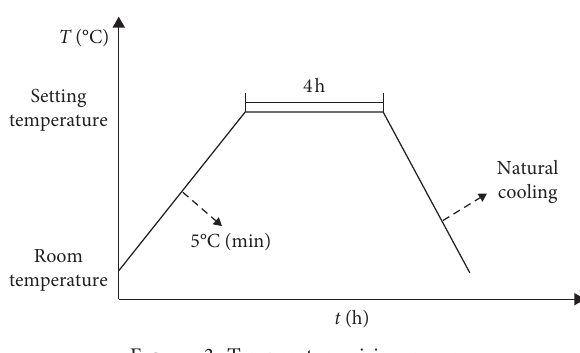
Figure 3: Temperature-rising